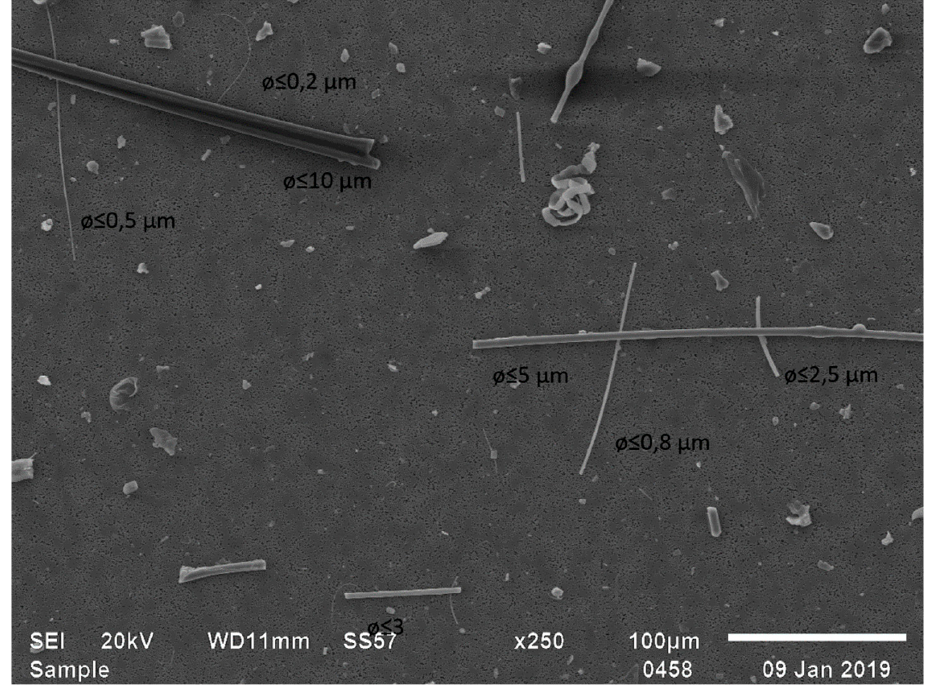
Figure 3. SEM image of fibers derived from Ecophon Gedina AT24 PE acoustic panels, Saint-Gobain Ecophon Oy, Finland.